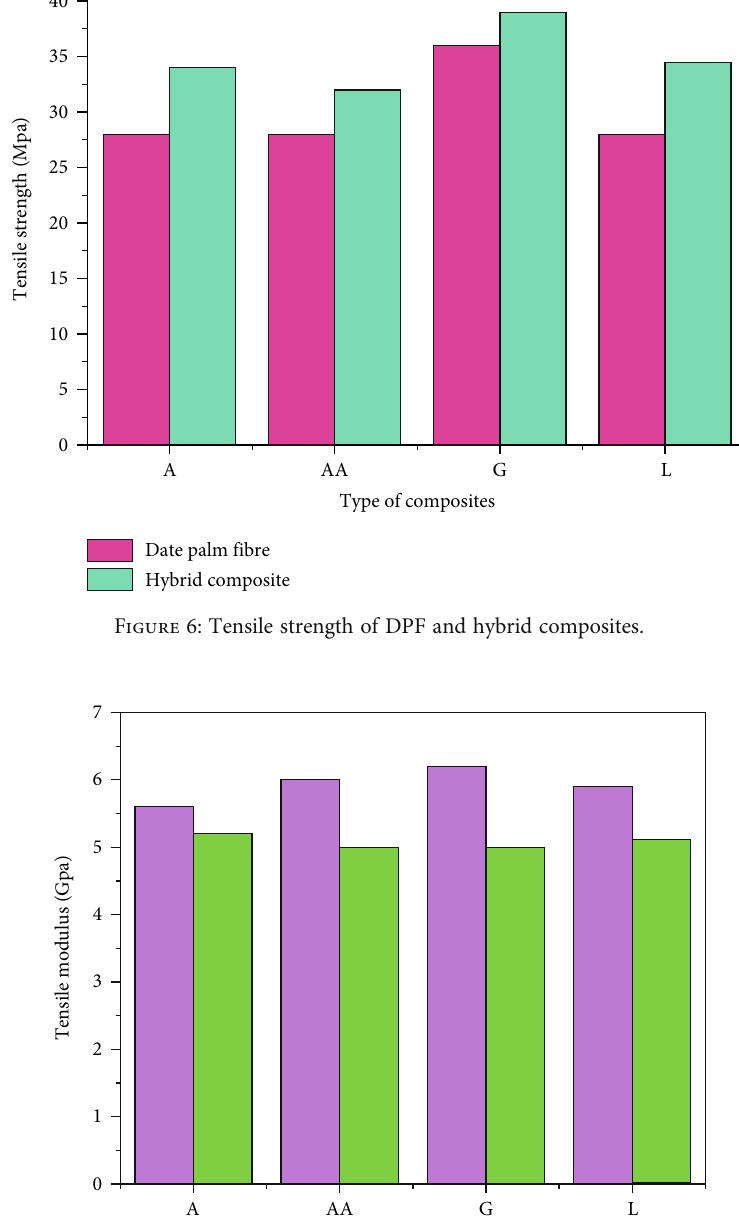
(date palm fi ber- G : 0.76 millimeters, date palm fi ber- A : 0.67 millimeters, date palm fi ber AA: 0.64 millimeters, and date